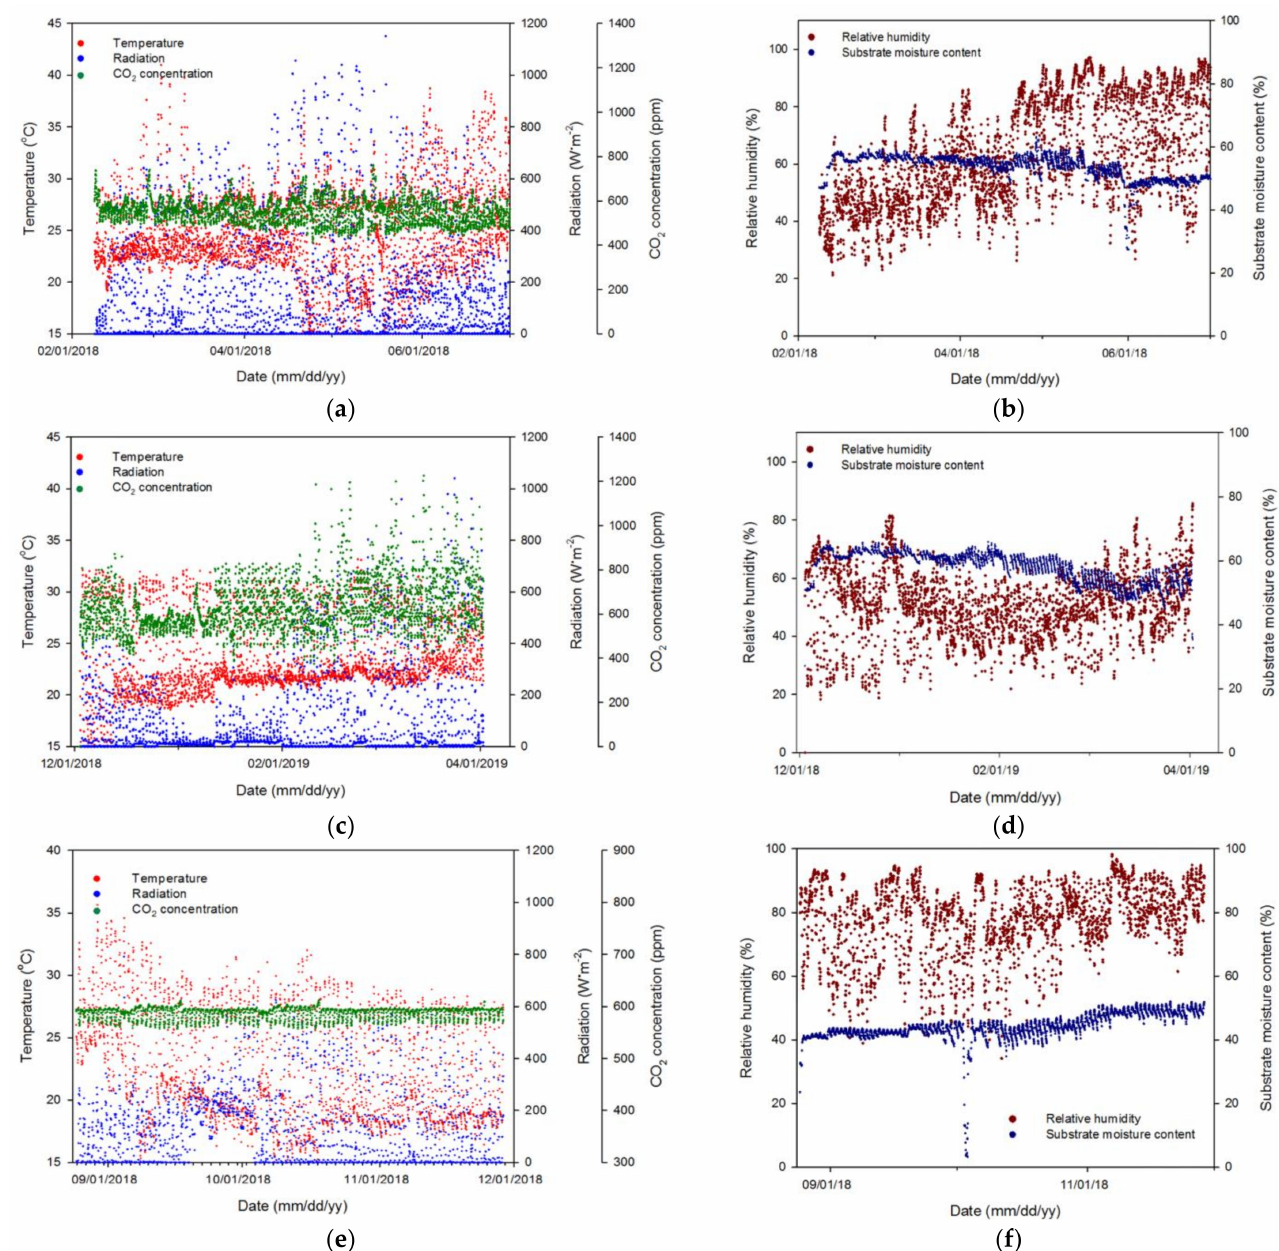
Figure 2. Environmental conditions (temperature, radiation, and CO 2 concentration) in the greenhouse during